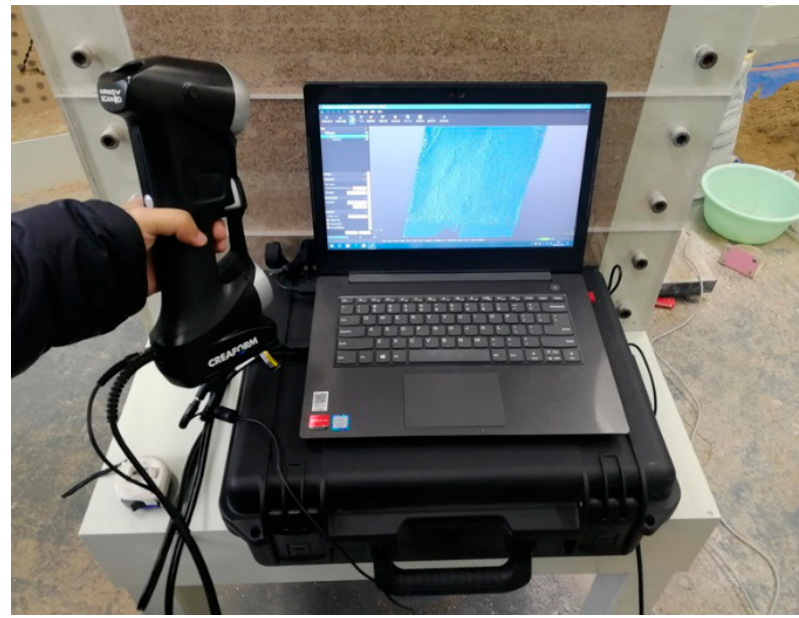
Figure 4. HandyScan700 three-dimensional scanner and support equipment.